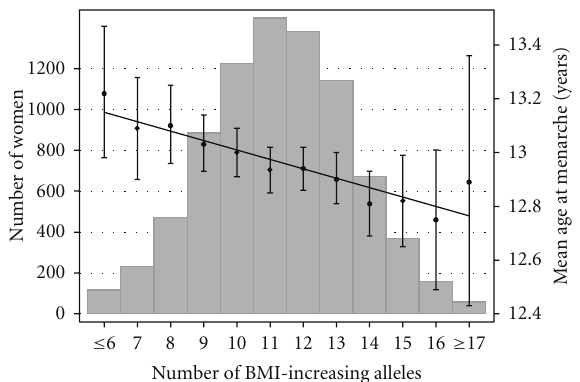
Figure 1: Histogram showing the distribution of the BMI- increasing-allele-score in EPIC-Norfolk women ( n = 8,156). Within each allele score category, the mean and 95% CI for age at menarche are shown by circles and error bars. The trend line shows the inverse linear trend between mean age at menarche and allele score